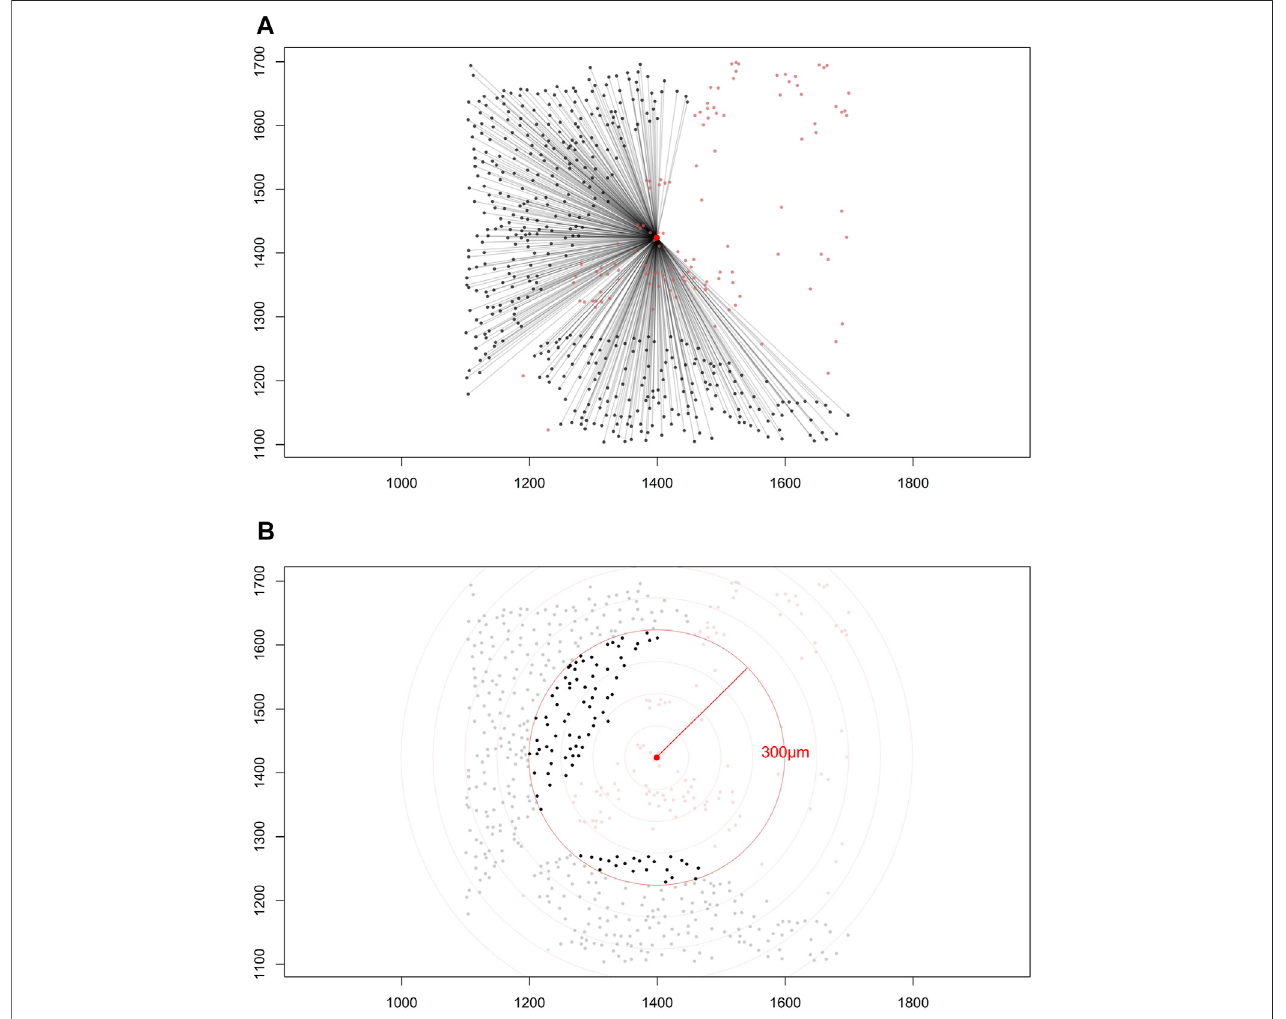
FIGURE5| Distancematrices. (A) Identi fi edcellcoordinatesanddistancemeasurementsfromonecellphenotype(reddots)toanothercellphenotype(blackdots) in a lung adenocarcinoma image. (B) The intensity of one cell phenotype (black dots) was calculated at a given radius (red circle, 300 μ m) from the other cell phenotype (red dots). The images were generated using R studio software version